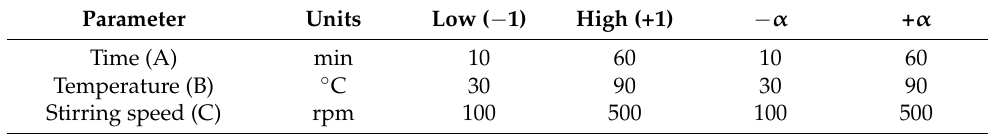
Table 2. RSM parameters for gold leaching.